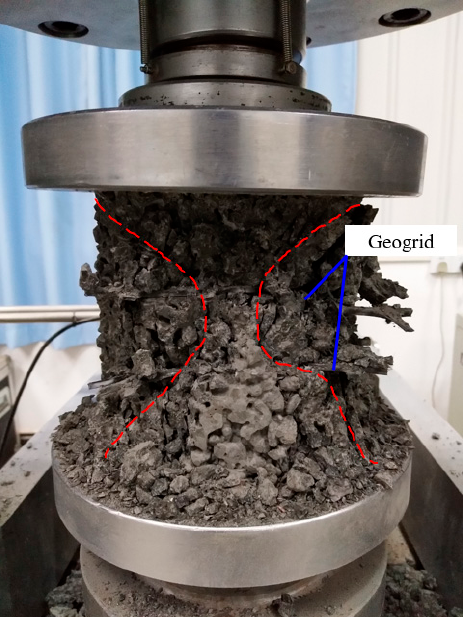
Figure 9. The typical failure model of a specimen under uniaxial loading.